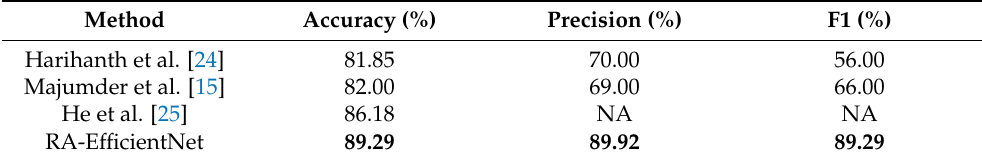
Table 9. Comparison with existing works for DR severity grades on EyePACS dataset.